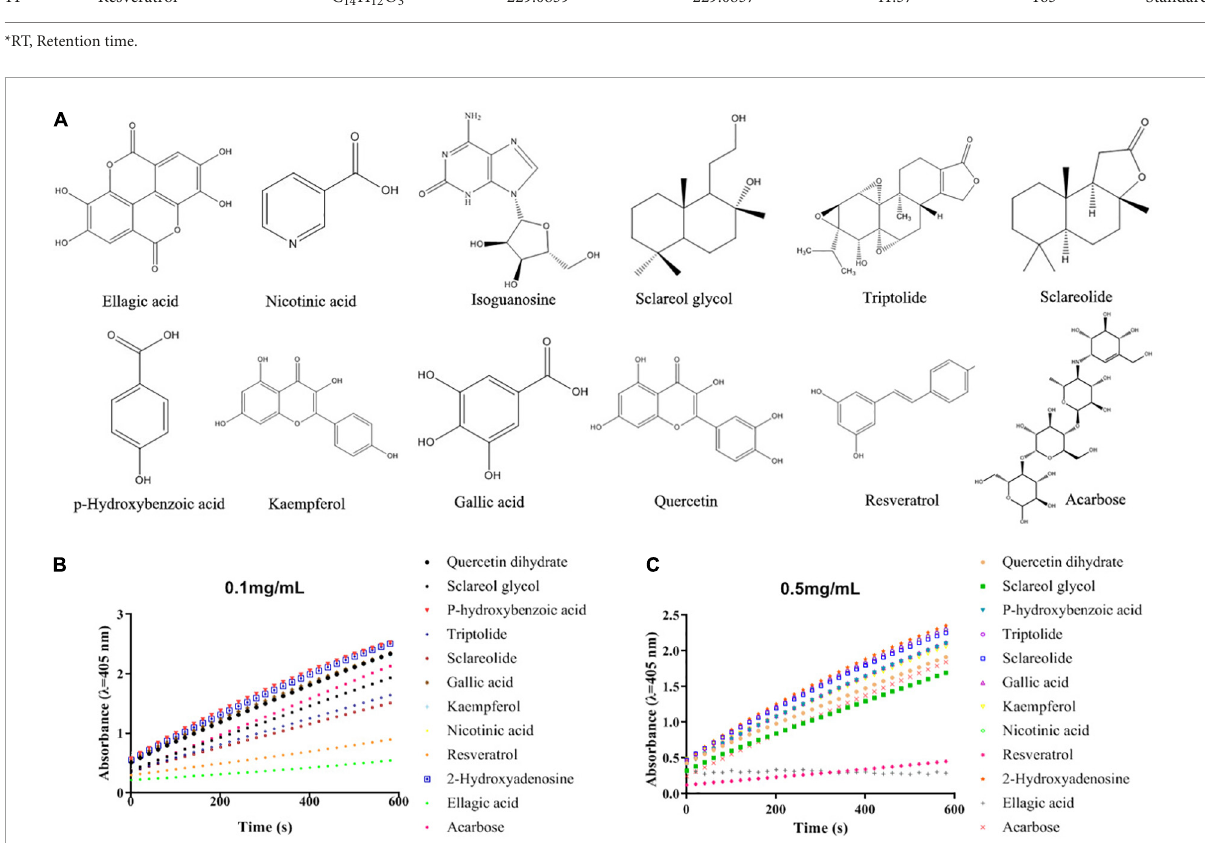
FIGURE1 The structures of acarbose and the screened α -glucosidase inhibitors from the acetone extract of pomegranate peel (A) and their α -glucosidase inhibitory activities under different concentrations [ (B) 0.1 mg/mL; (C) 0.5